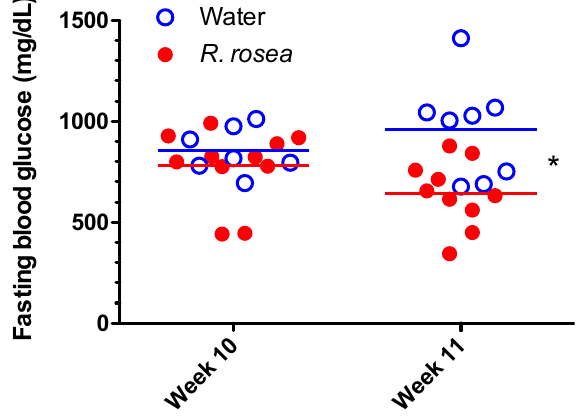
Figure 2. Rhodiola rosea improves fasting blood glucose in db/db mice. Folowing a 4 h fast, blood glucose levels were determined at the end of treatment (week 10) and 1 week later. The difference in mean blood glucose level at week 11 was significant (* P = 0.0303, repeated measures ANOVA). n = 8 control, n = 11 R. rosea -treated; one control sample from week 10 and one R-rosea -treated sample from week 11 did not give interpretable results and were omitted.